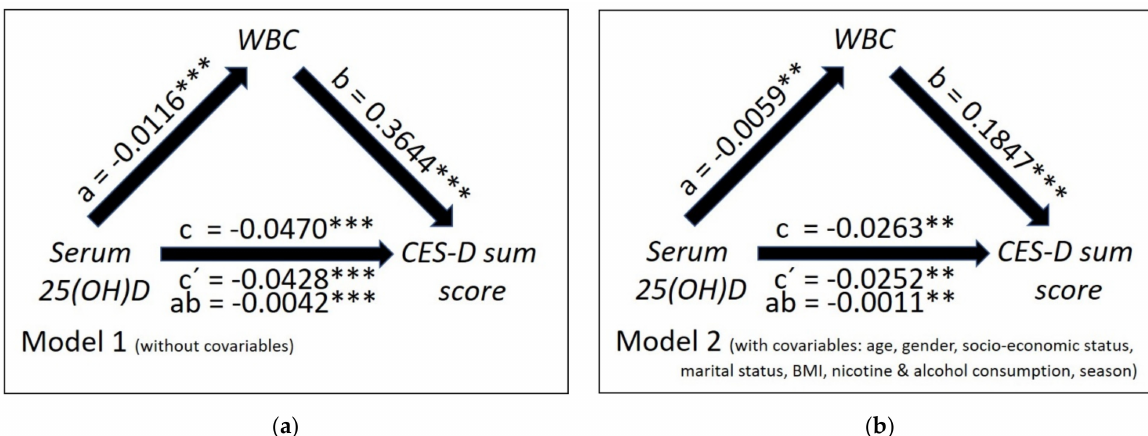
Figure 4. Mediation model without ( a ) and with covariates ( b ) showing both the total and direct effect of serum 25(OH)D concentrations on the intensity of depressive symptomatology as measured by CES-D sum scores (path coefficients c and c (cid:48) ) and the indirect effect of serum 25(OH)D concentrations on CES-D scores mediated through white blood cell (WBC) count (path coefficient ab) in the study sample. The figure depicts the unstandardized path coefficients (a,b,c,c (cid:48) and ab; with ** p < 0.010; *** p <